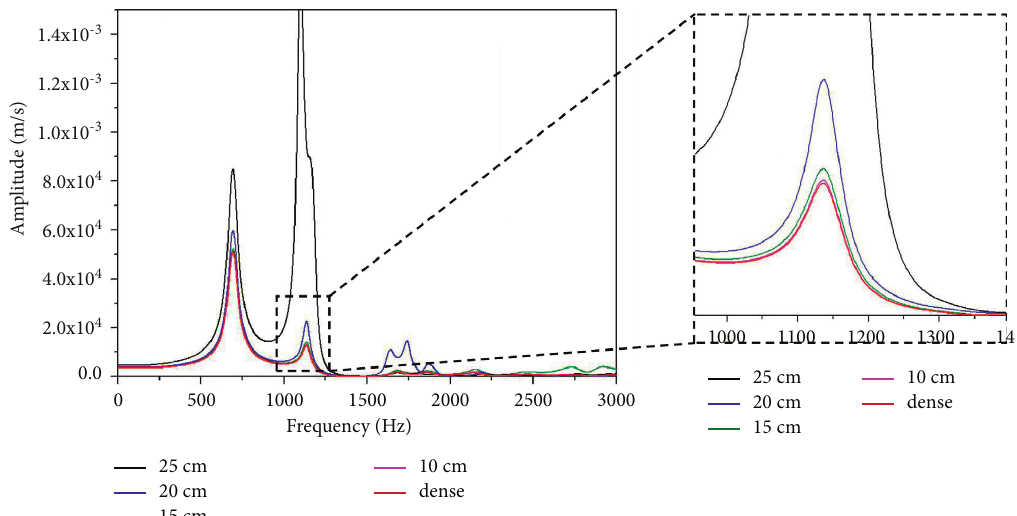
Figure 9: Response waveform frequency spectrum under different defect lengths.